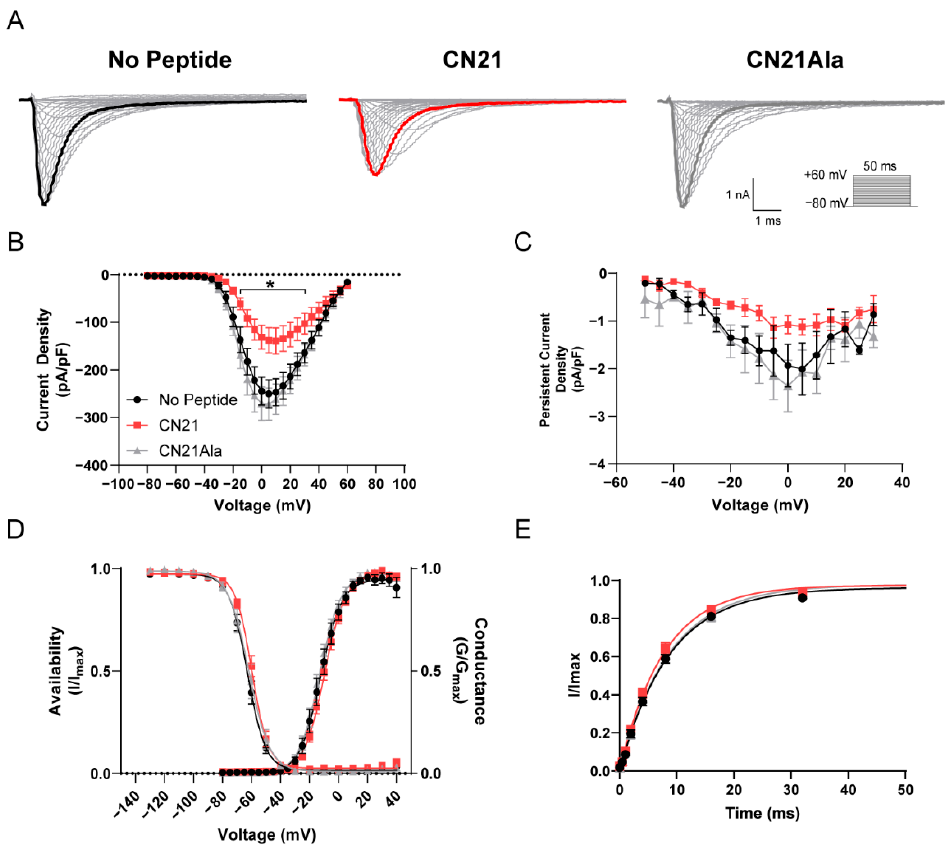
Figure 7. CaMKII inhibition decreases R639C mutant current density. ( A ) Representative family of current traces generated by Nav1.6 mutant R639C with no peptide (black, left), CN21 (red, middle), or CN21Ala (gray, right) in the patch pipette elicited with a voltage-step protocol (inset). Peak current traces are in boldface. ( B ) Transient current density–voltage and ( C ) persistent current density–voltage curves. ( D ) Voltage dependence of activation and availability curves, each fitted with a Boltzmann function. ( E ) Rate of recovery from fast inactivation. CaMKII inhibition reduces R639C current density with no additional changes in biophysical properties. * p < 0.05; n = 4–11 per group; two-way ANOVA ± SEM (error bars), Tukey’s post hoc test.